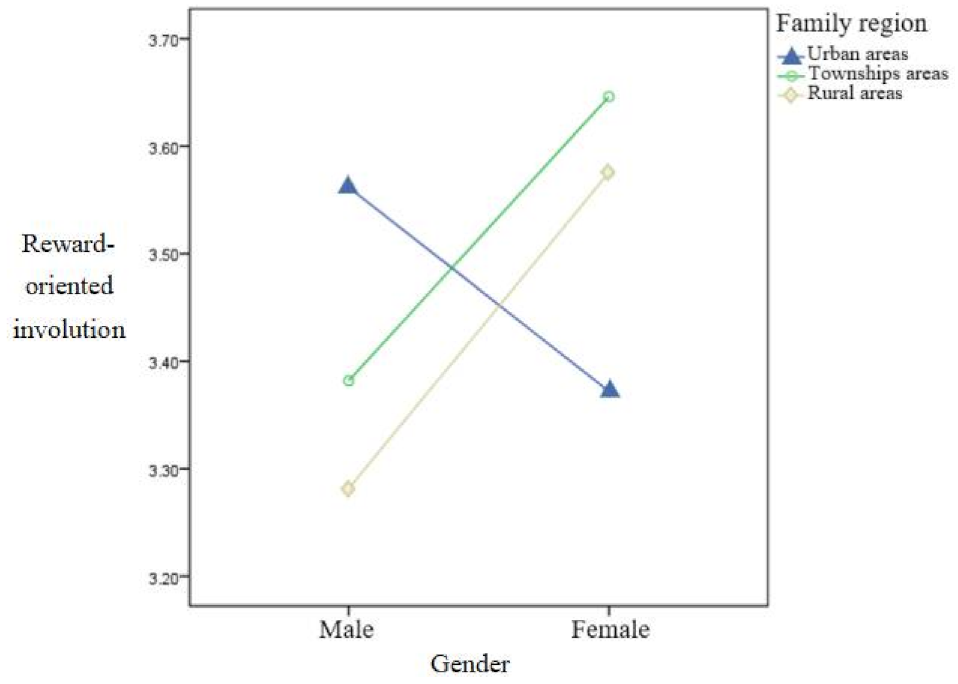
Figure 2. The interaction diagram of gender and family region for reward-oriented involution. n =